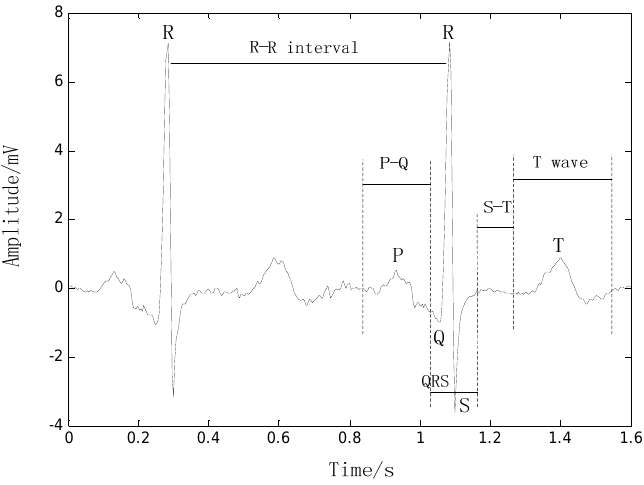
Figure 1. Classical wave profile of an ECG